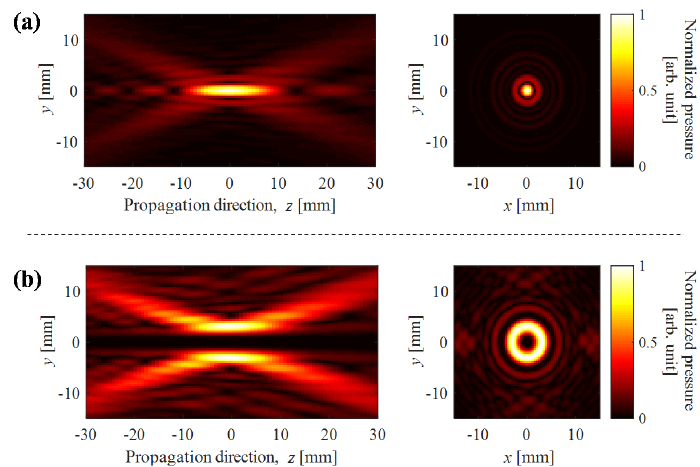
Figure 2. Ultrasound pressure field simulated by assuming linear propagation and neglecting attenuation. ( a ) without focal steering; ( b ) directly synthesized focus by a sector vortex method with a vortex mode number of 4.